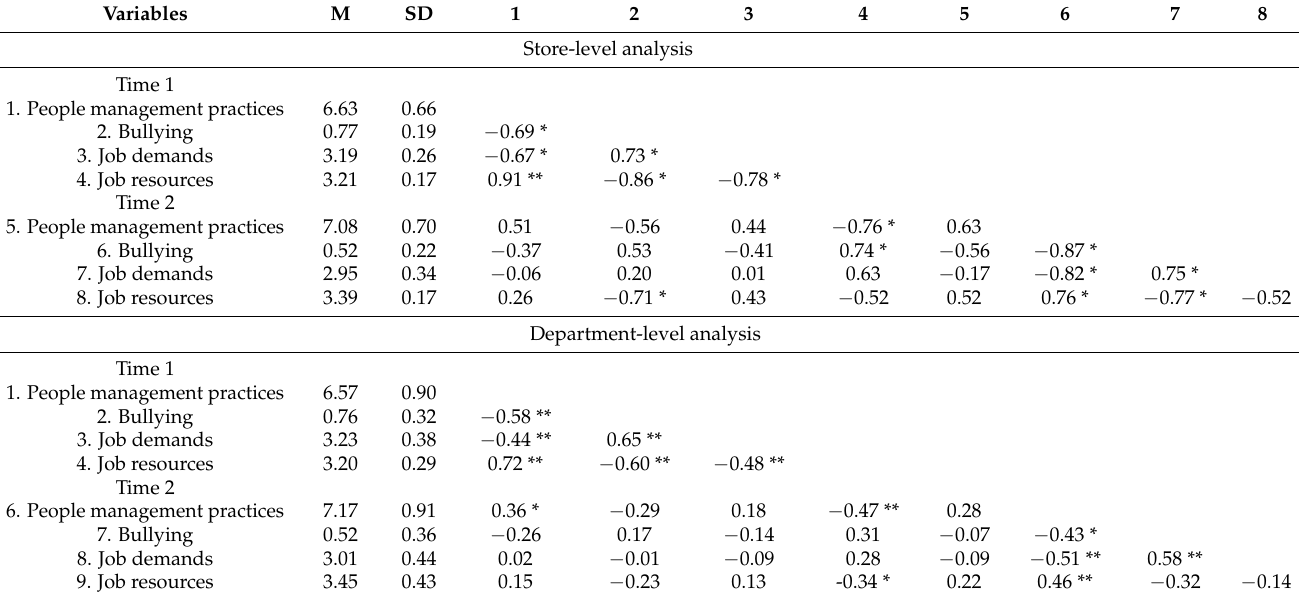
Table 3. Descriptive statistics and intercorrelations of the study